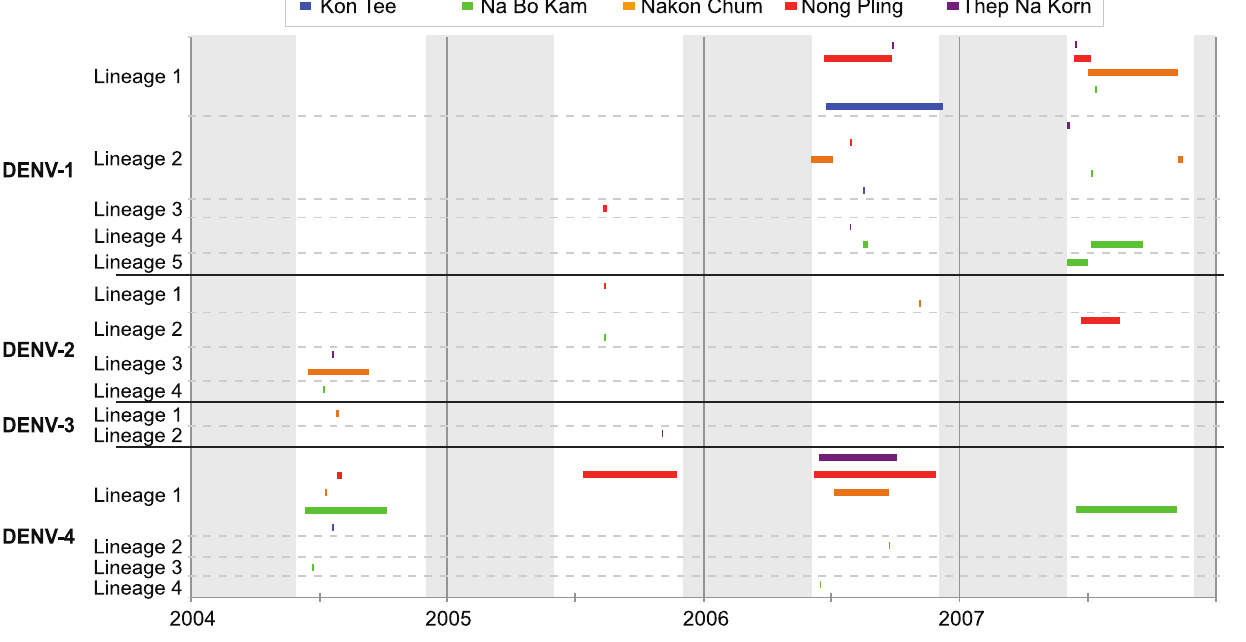
PLOS Neglected Tropical Diseases |